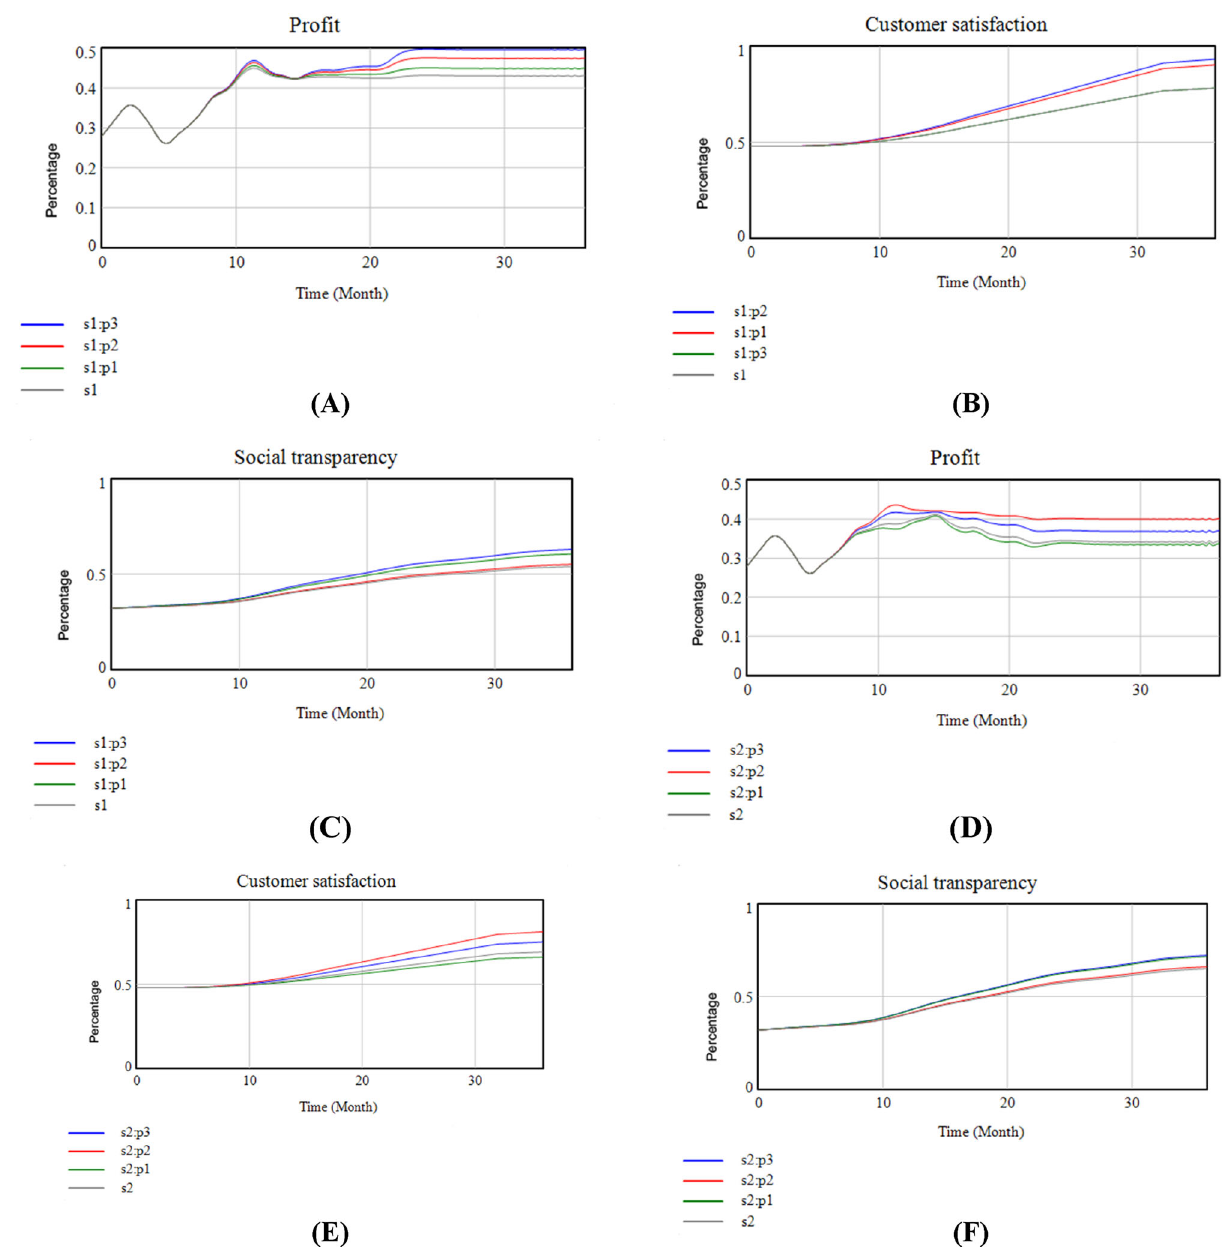
Fig. 14 Different policies under the two